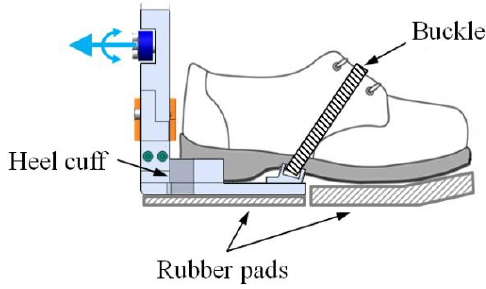
Figure 5. Foot configuration of the exoskeleton. The forefoot is free to be bent for ensuring smooth ground contact.